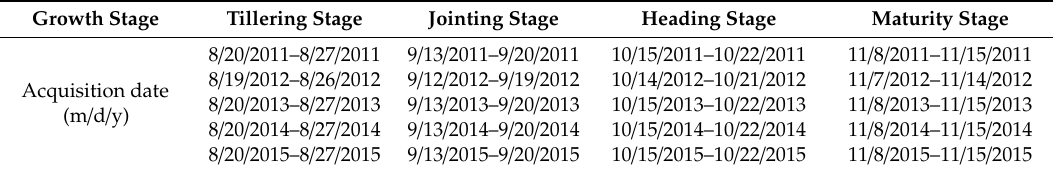
Table 1. Acquisition dates of MODIS-GPPs and corresponding with rice growth